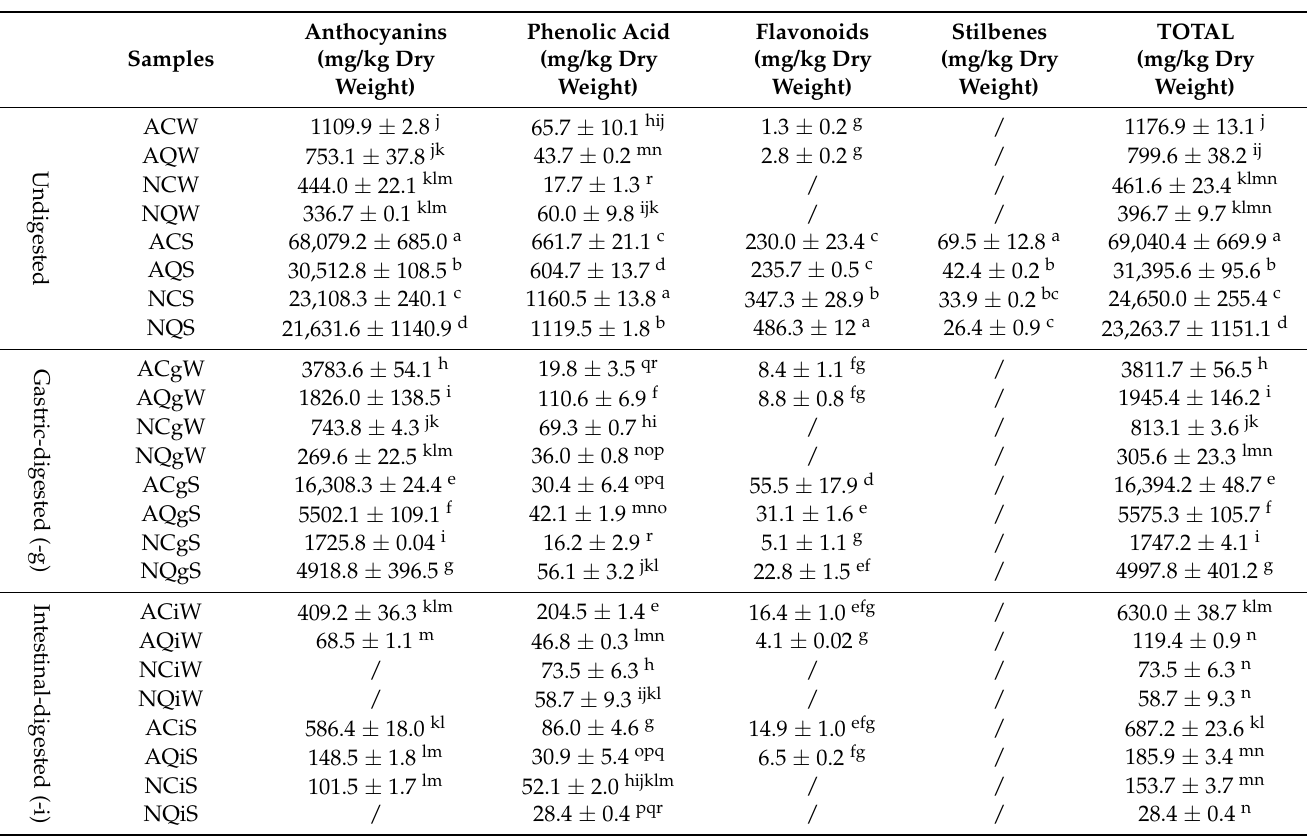
Table 2. Quantified sample content (mg/kg dry weight ± SD) of the main classes of phenolic compounds by the UHPLC-DAD